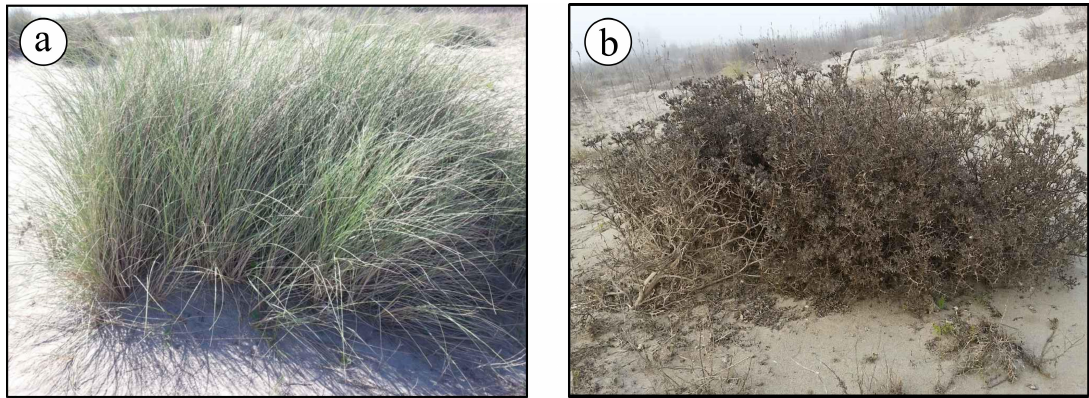
Figure 8. Botanical species of vegetation on the dunes: ( a ) Ammophila arenaria ; ( b ) Echinophora spinosa .